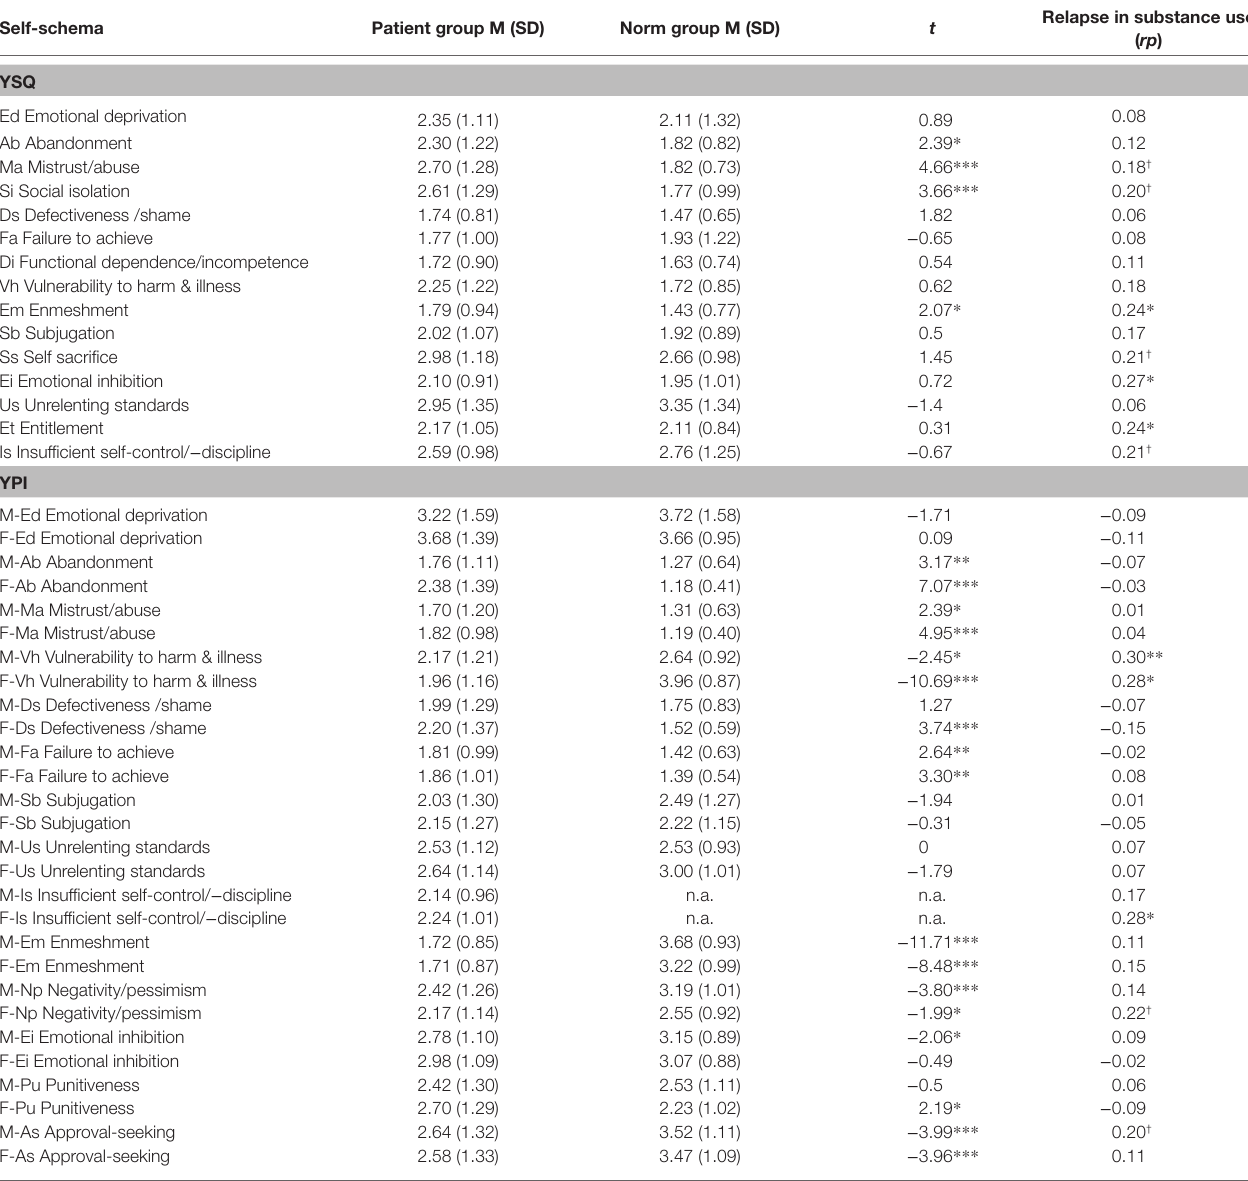
TABLE 2 | YSQ-S- and YPI (M = mother/F = father) subscales (mean scores, standard deviation) for patients in treatment for opiate addiction compared to normative values (non-clinical groups) and subscales correlations with relapse in substance use during treatment ( rp ). Self-schema Patient group M